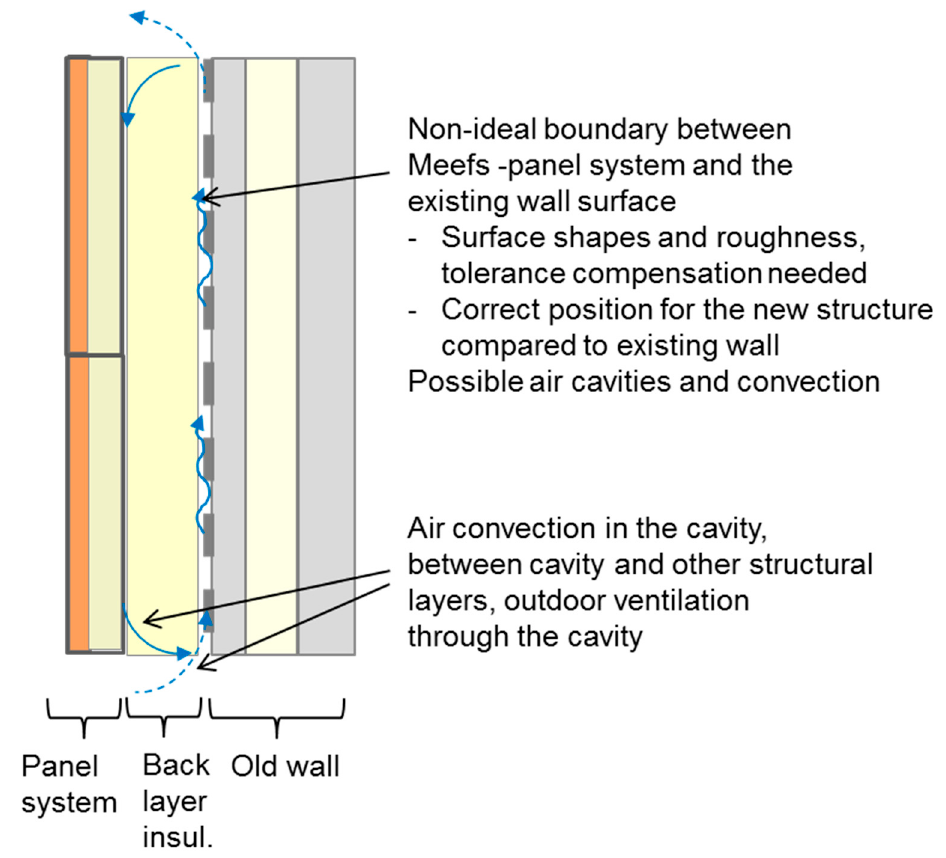
Figure 5. Non-ideal contact between the structure elements of the Meefs panel system and the existing wall may result in uncontrolled ventilation in the structure. This may a ff ect the thermal and moisture performance of the